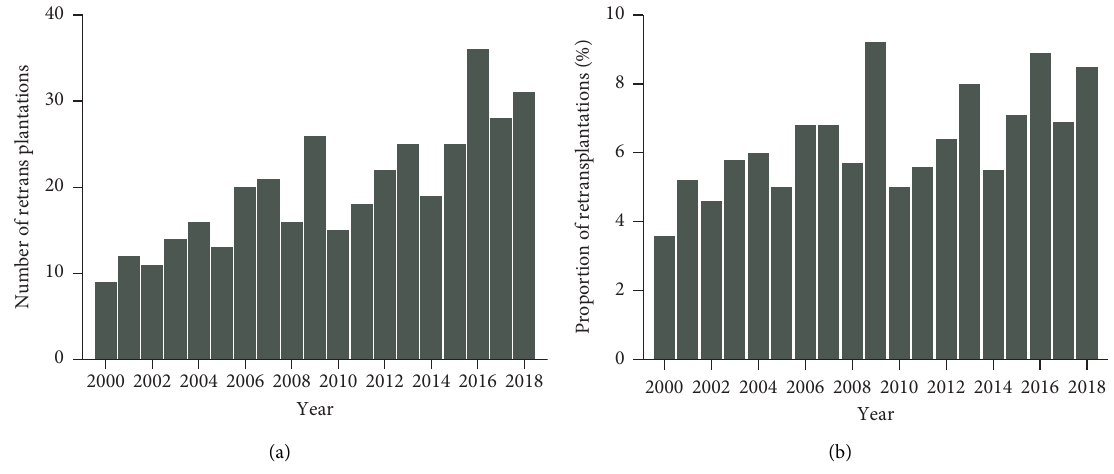
Figure 1: Number and proportion of retransplantations by year from 2000 to